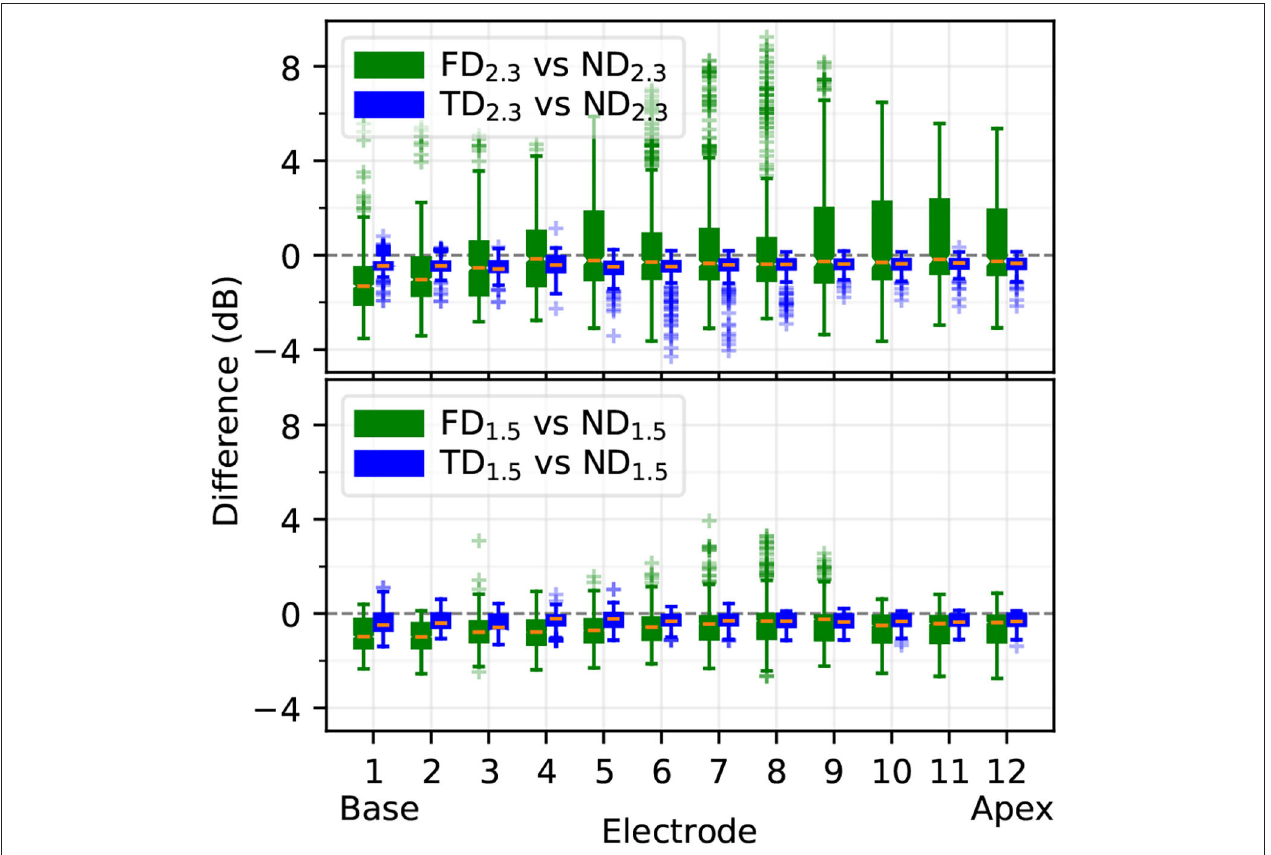
FIGURE 9 | Difference of individual ANF thresholds between ND and other degenerative states, computed as in Equation 1. Boxplots show medians, lower and upper quartiles, whiskers (encompassing values contained in quartiles ± 1.5 times the interquartile range), and outliers.